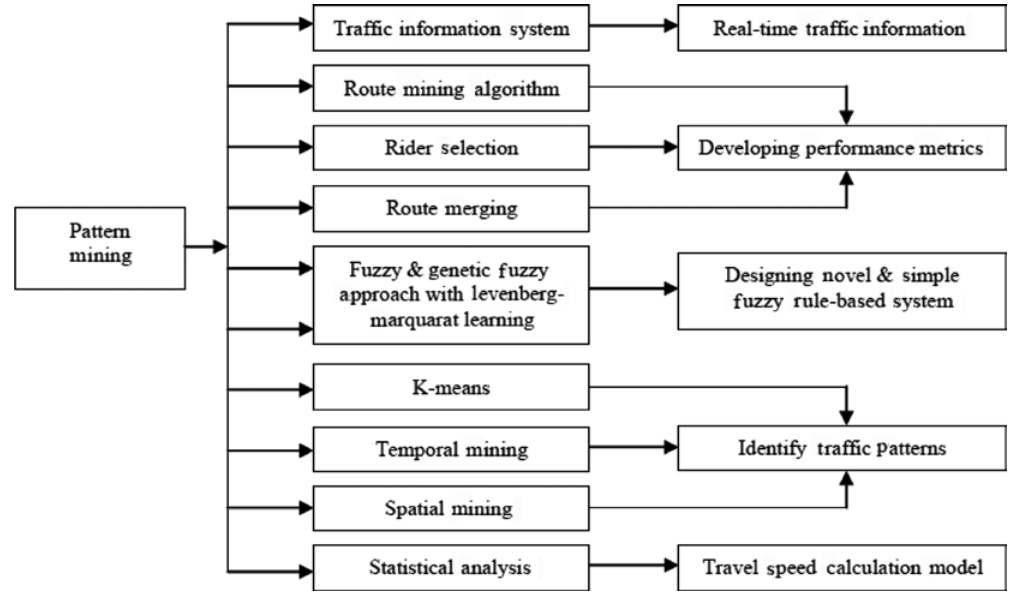
Figure 4: List of Pattern Mining Methods Used in Intelligent Transportation